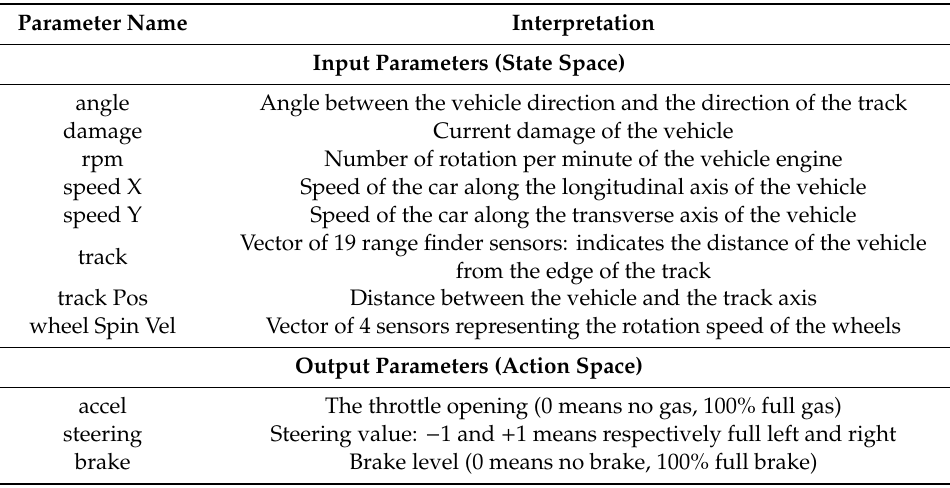
Table 2. Driving decision system input and output parameters.